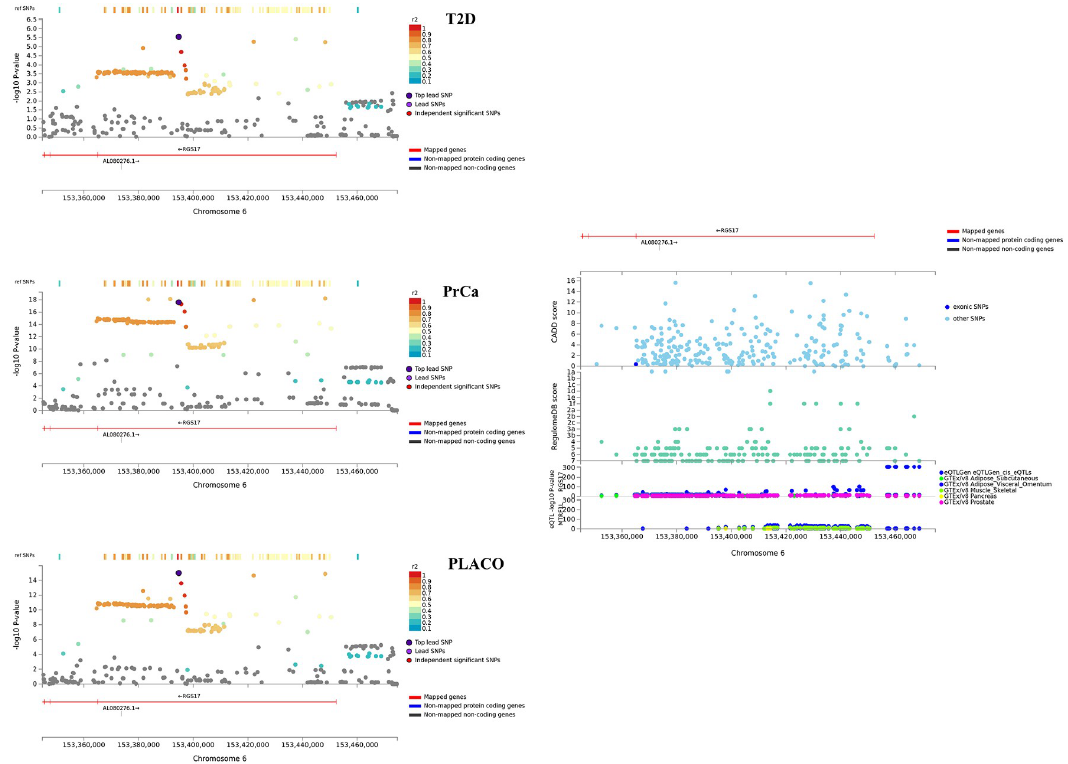
Fig 5. Regional association plot of significant pleiotropic locus near RGS17 with annotations such as CADD scores, RegulomeDB scores, and cis eQTL association p-values from 6 tissues. Tissues considered are whole blood from eQTLGen Consortium; and adipose, liver, muscle-skeletal, pancreas, and prostate tissues from GTEx